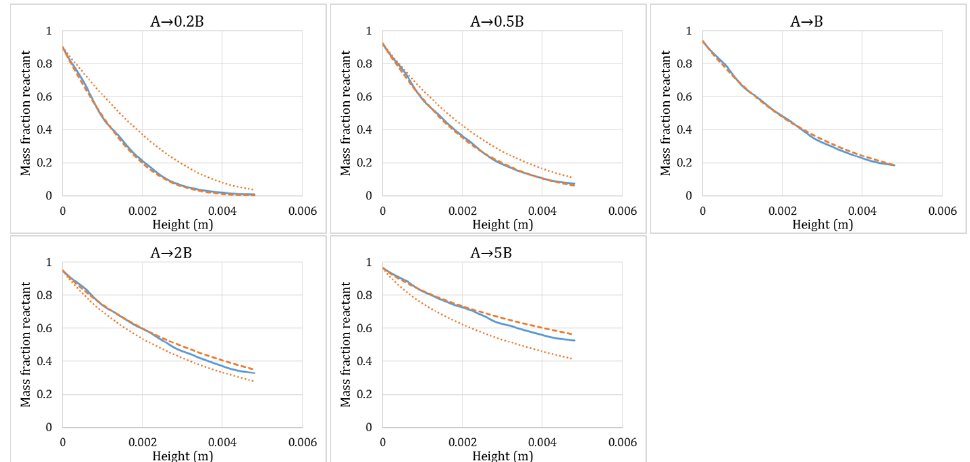
Figure 9. Comparison of mass fraction of the reactant (specie A) along the height of the reactor between PR-DNS (solid lines), modified 1D model (dashed lines), and 1D model (dotted lines) for different reaction cases in Table 3. The dotted lines represent the 1D model predictions without accounting for gas volume generation. The inlet specie concentration in the case of the 1D model has been adjusted to account for faster specie conversion at the inlet in PR-DNS results.